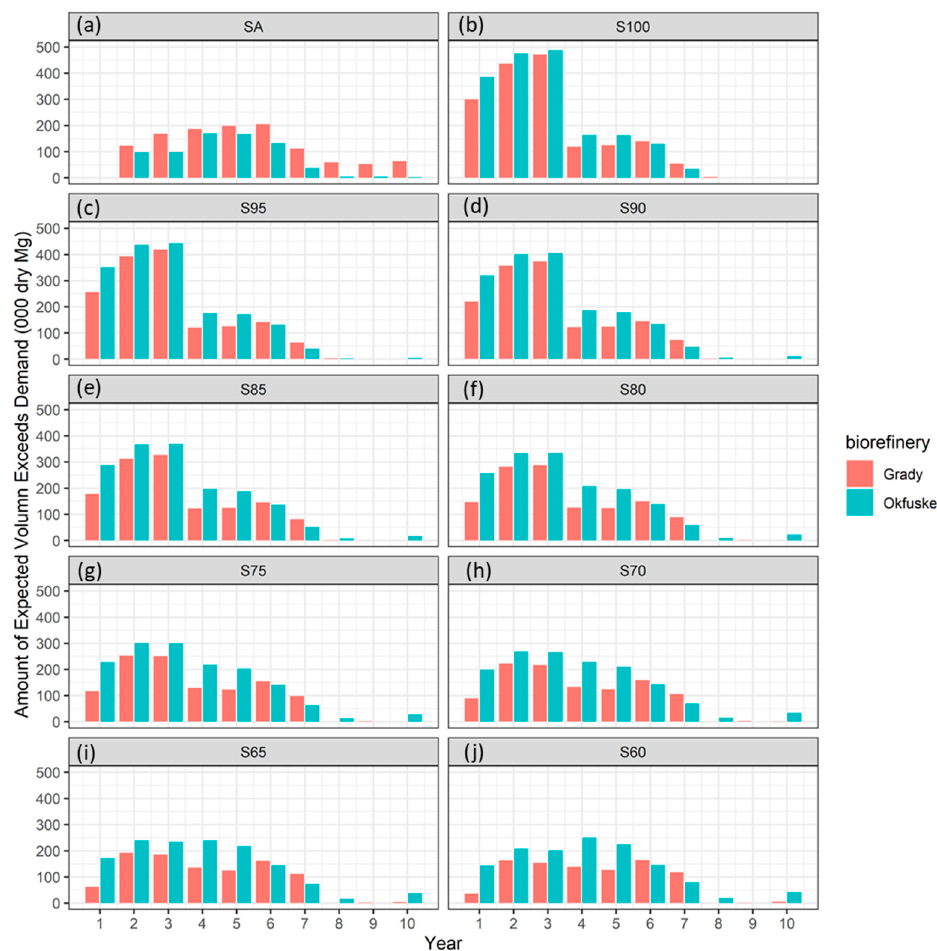
Figure 4. Expected biomass volume exceed annual demand under different scenarios. ( a ) SA-100% of the time the biorefinery annual demand can be met; ( b ) S100-probability of meeting biorefinery demand is 35% ,45%, and 55% for the first three years respectively, and 100% for years 4 to 10; ( c ) S95- probability of meeting biorefinery demand is 35% ,45%, and 55% for the first three years respectively, and 95% for years 4 to 10; ( d ) S90- probability of meeting biorefinery demand is 35% ,45%, and 55% for the first three years respectively, and 90% for years 4 to 10; ( e ) S85- probability of meeting biore- finery demand is 35% ,45%, and 55% for the first three years respectively, and 85% for years 4 to 10; ( f ) S80- probability of meeting biorefinery demand is 35% ,45%, and 55% for the first three years respectively, and 80% for years 4 to 10; ( g ) S75- probability of meeting biorefinery demand is 35% ,45%, and 55% for the first three years respectively, and 75% for years 4 to 10; ( h ) S70- probability of meeting biorefinery demand is 35% ,45%, and 55% for the first three years respectively, and 70% for years 4 to 10; ( i ) S65- probability of meeting biorefinery demand is 35% ,45%, and 55% for the first three years respectively, and 65% for years 4 to 10; ( j ) S60- probability of meeting biorefinery demand is 35% ,45%, and 55% for the first three years respectively, and 60% for years 4 to 10.